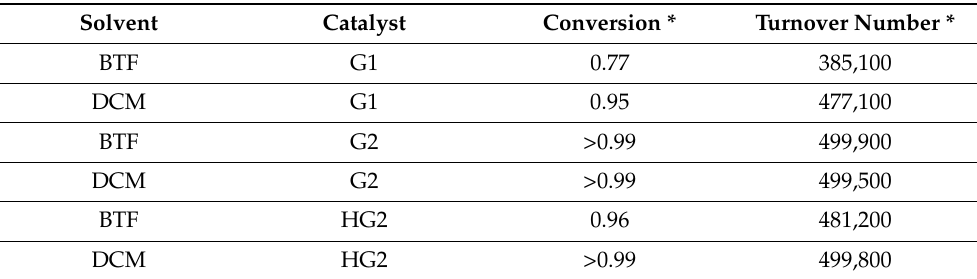
Table 2. The solvent, the catalyst type, the conversion, and the turnover number for the ring- opening metathesis polymerization of norbornene (c 0 = 106 mM) conducted in benzotrifluoride and dichloromethane under a nitrogen atmosphere for 78